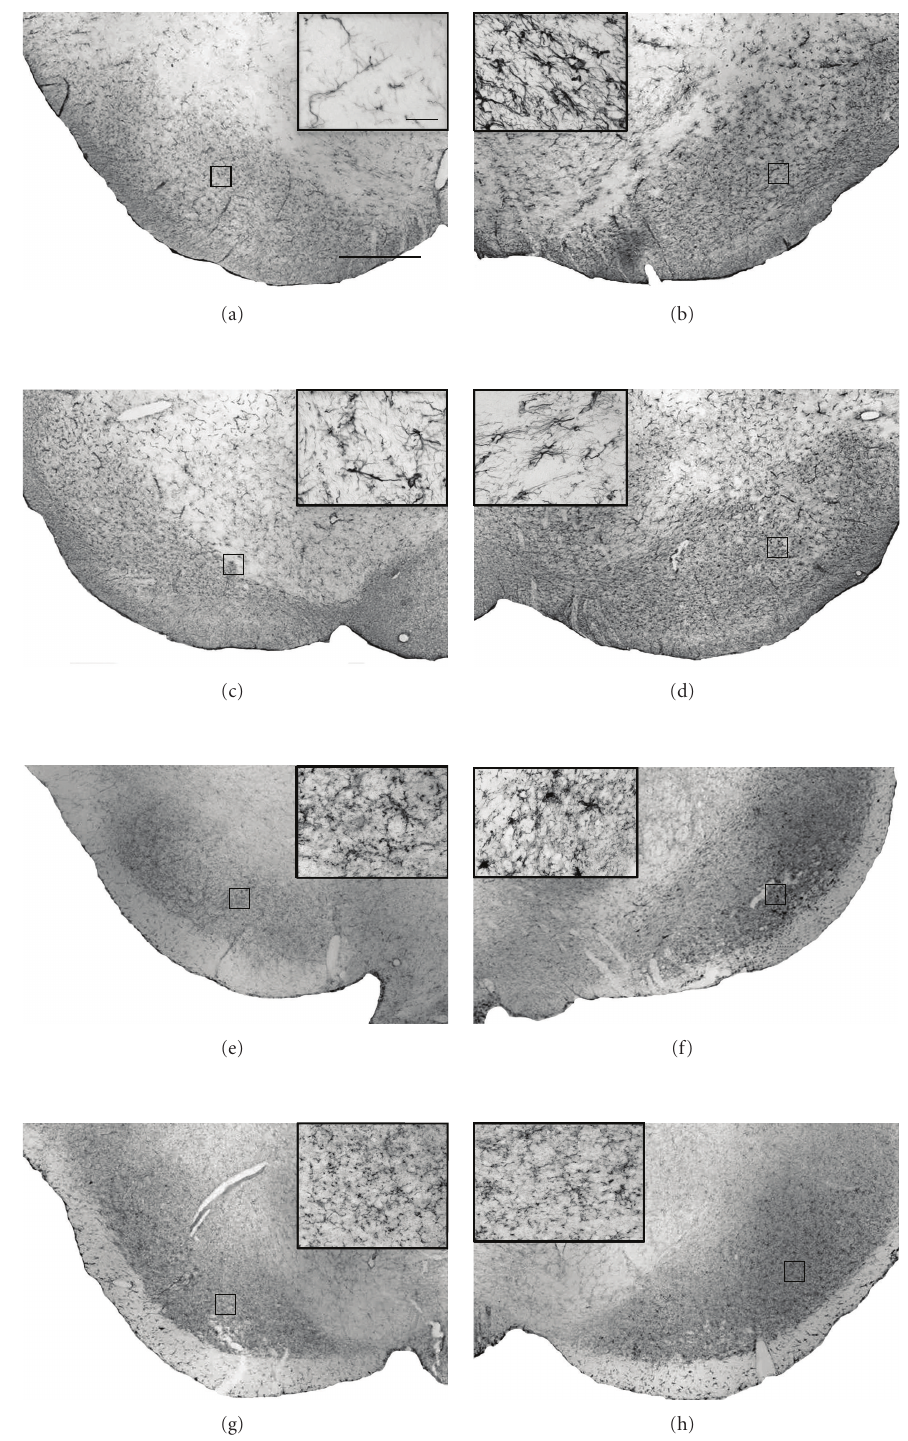
Figure 3: Neuroprotection against 6-OHDA toxicity following delayed subchronic intranigral administration of 2 R ,4 R -APDC is associated with qualitative reductions in inflammatory markers. Representative photomicrographs ( × 40) of DAB/peroxidase staining for GFAP (astrocytosis) and OX-42 (microgliosis) in the SNc from each treatment group (scale bar 200 μ m.). Panels (a)–(g) show the intensity and distribution of GFAP+ and OX-42+ cells in the contralateral control SN of vehicle (a), (c) and (e), (g) 2 R ,4 R -APDC (10nmol)-injected animals. Panels (b)–(h) show the intensity and distribution of GFAP+ and OX-42+ cells in the Lesioned SNc of vehicle (b), (d) and (e), (g) 2 R ,4 R -APDC (10nmol)-injected animals. (Insets (a)–(h)), × 60, enlargements of outlined areas (scale bar 10 μ m)). Note the apparent reduction in intensity of GFAP+ and OX-42+ staining in 2 R ,4 R -APDC-injected animals compared to vehicle-treated animals. Further, 2 R ,4 R -APDC treatment appeared to reduce the number of cells with morphology characteristic for reactive astrocytes or activated microglia in the SNc in comparison to vehicle-treated